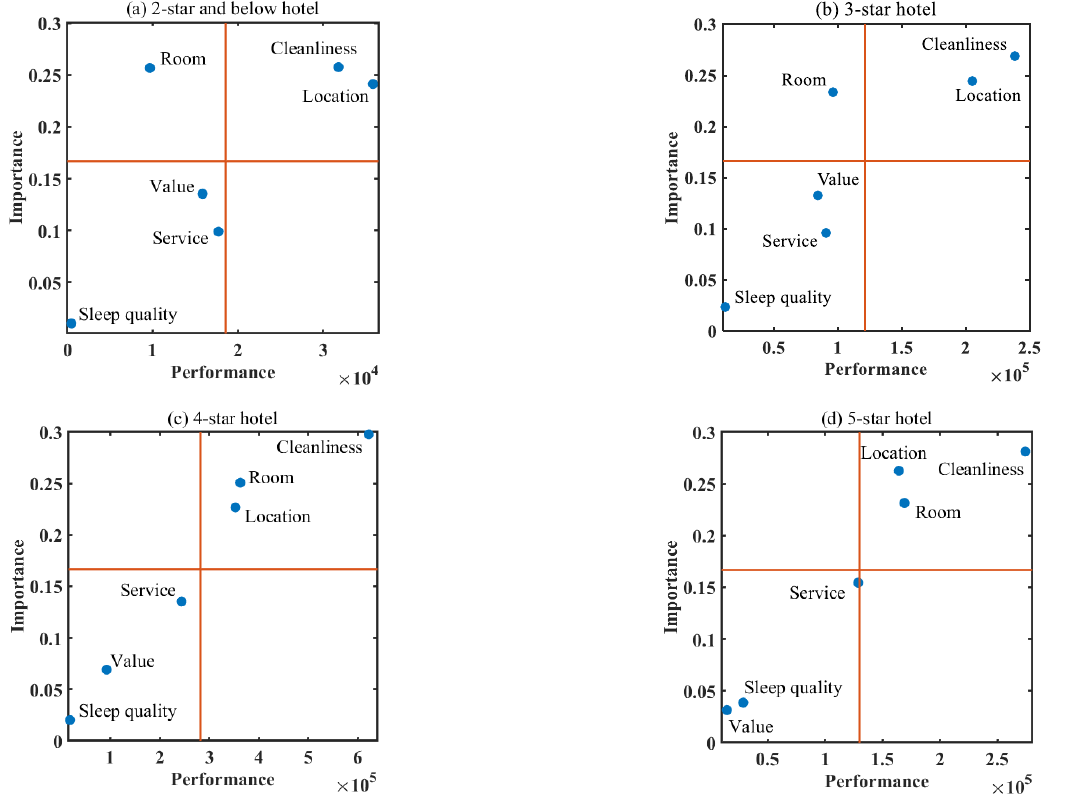
Figure 7. The IPA plots concerning four hotel star ratings.